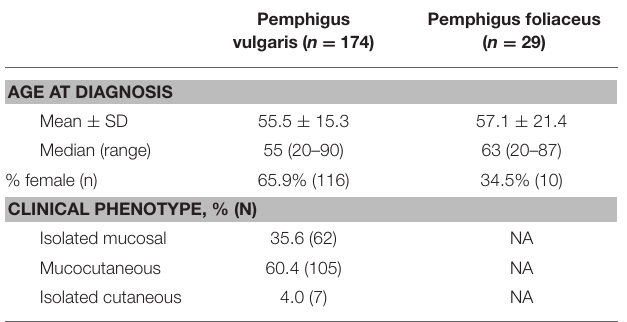
TABLE 1 | Demographic and clinical characteristics of patients with pemphigus whose sera were tested by indirect immunofluorescence microscopy. Pemphigus vulgaris ( n = 174)